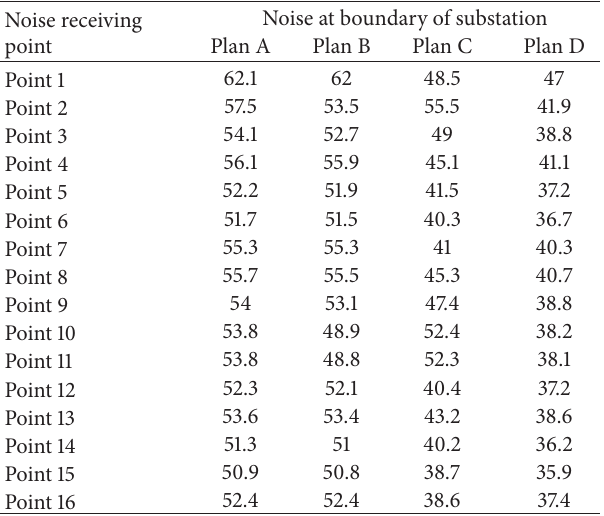
Table 2: Prediction of noise at boundary of Lanchow 330 kV sub- station